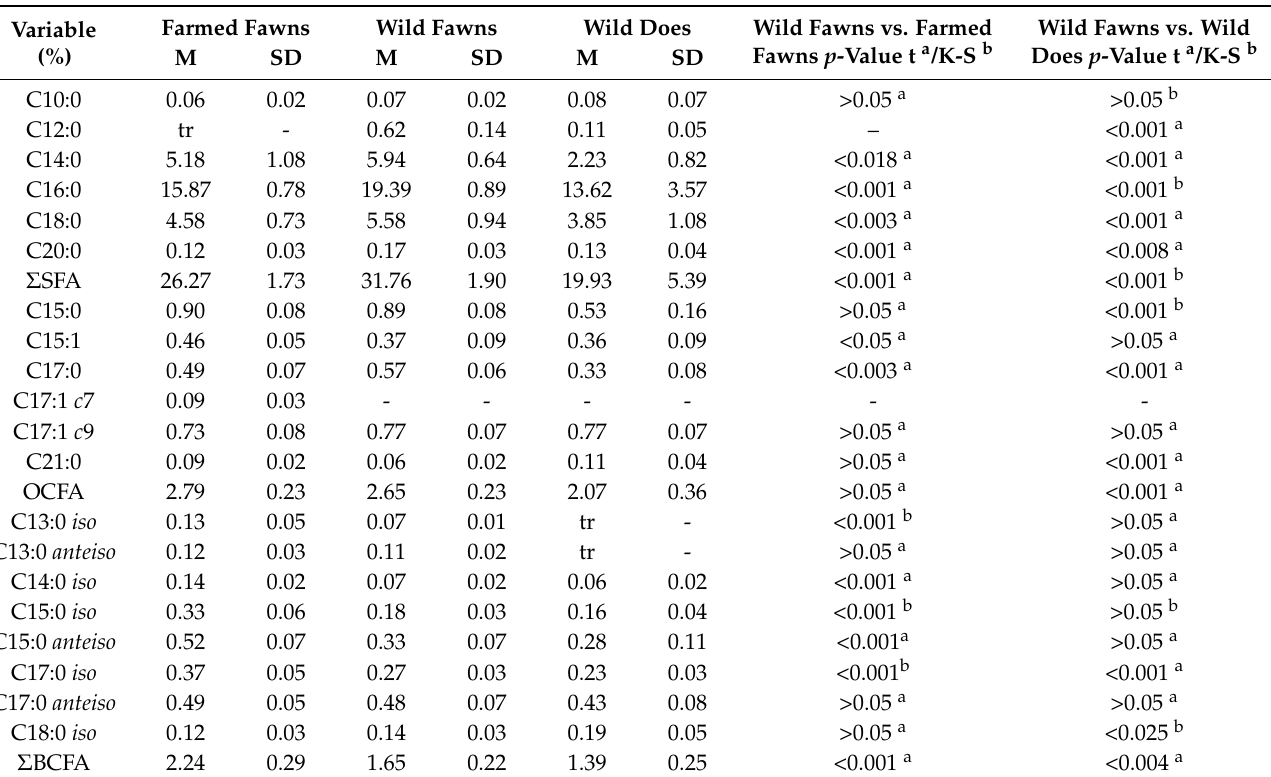
Table 2. Saturated, odd-, and branched-chain fatty acid composition in the bone marrow of red deer fawns and